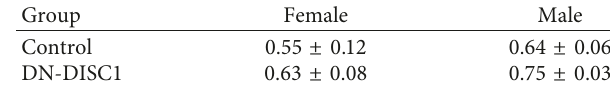
Table 1: Toxoplasma gondii IgG. Group